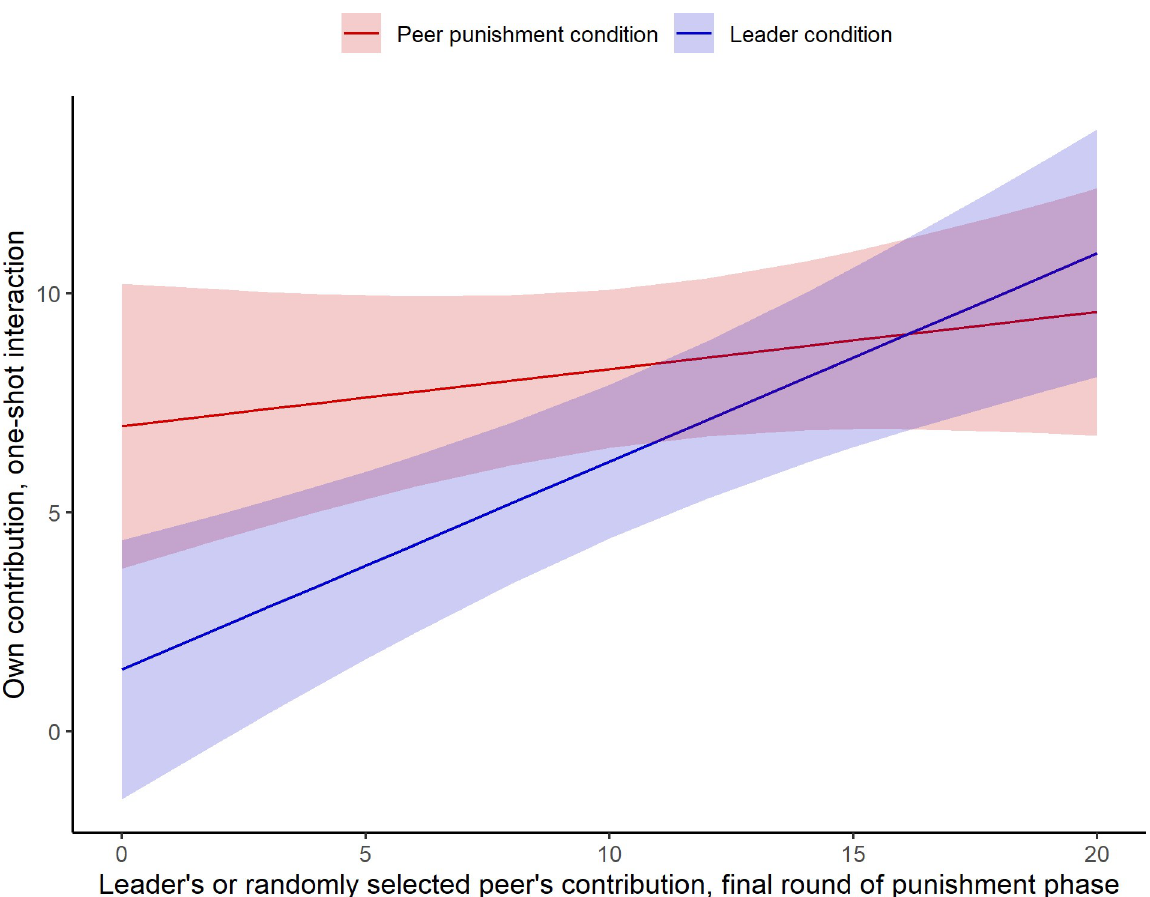
Fig 3. The effect of the leader’s contribution, vs. a peer’s contribution, on promoting cooperation in a subsequent, anonymous one-shot interaction. Note : Fig 3 displays estimates for contributions in the one-shot dilemma, as predicted from the model given in the paragraph above.